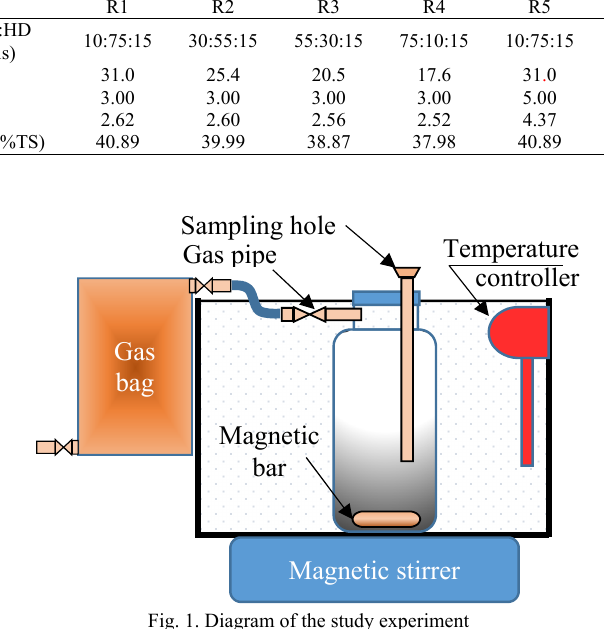
Fig. 1. Diagram of the study experiment